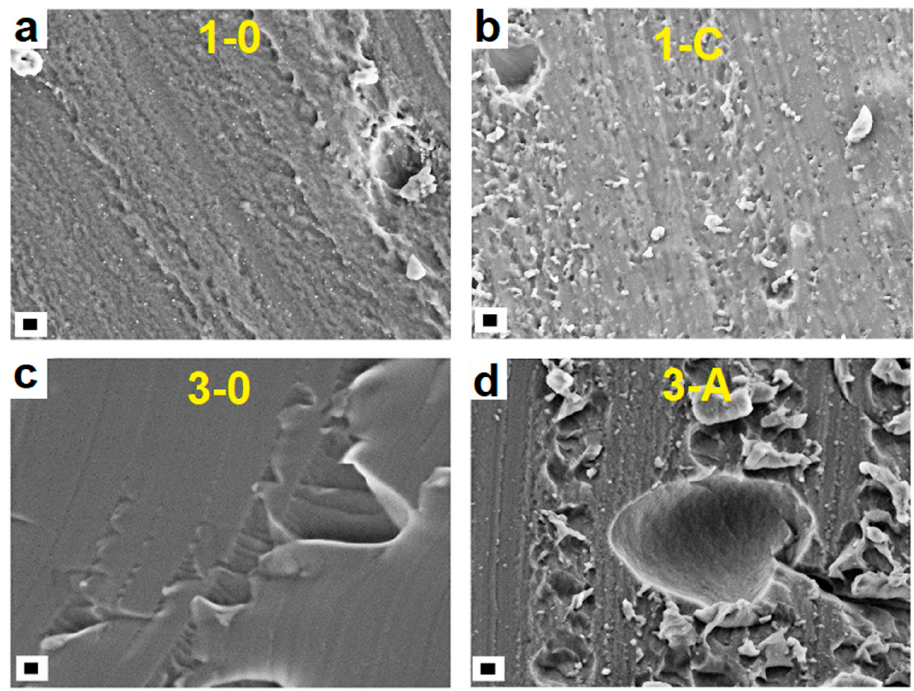
Figure 3. SEM images of ( a ) sample 1–0 with 14%wt of PEGDA and without AgNCs; ( b ) sample 1-C with 14%wt of PEGDA and 255 mg of AgNCs-PMAA; ( c ) sample 3–0 with 24%wt of PEGDA and without AgNCs; ( d ) sample 3-A with 24%wt of PEGDA and 180 mg of AgNCs-PMAA (scale bar 1 µm).